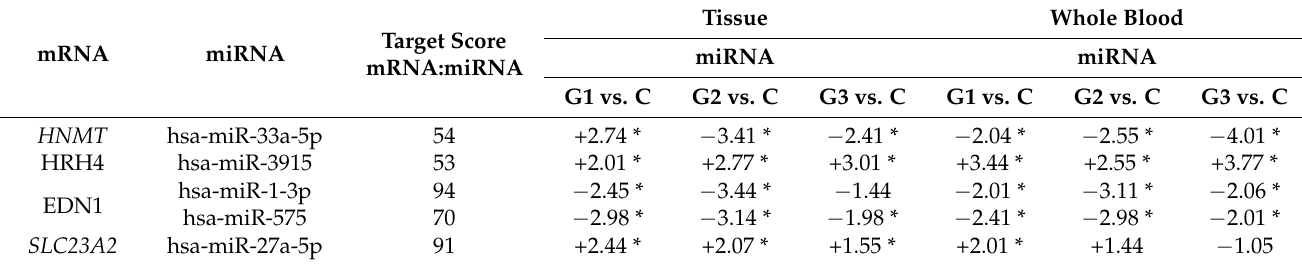
Table 6. Expression profile of miR-33a-5p, miR-3915, miR-1-3p, miR-575, and miR-27a-5p in endometrial tissue and whole blood of patients with endometrial cancer, compared to the control.